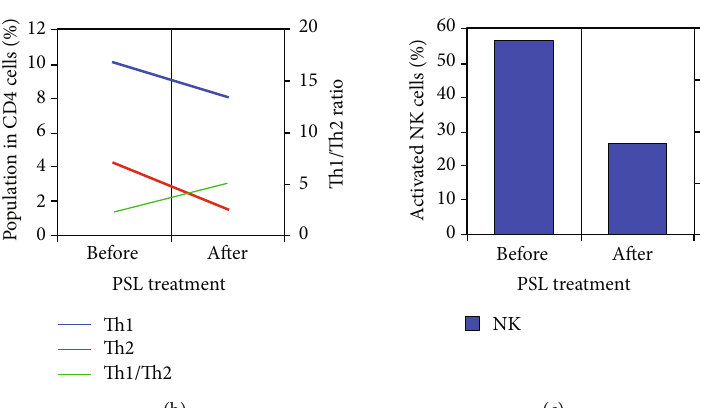
Figure 2: (a, A) Enhanced sensitivity of IL-12R and IL-23R leads to the di ff erentiation of naïve CD4+ cells to Th1 and Th17 cells (red arrows). (B) IL-1, produced mainly by macrophages, increases the number of Th2 cells via PGE2, and IL-12 and IL-18-activate NK cells (red arrows). (C) When Th17 induction is strong, the induction of regulatory T cells (Tregs) reduces (blue arrow), and immune tolerance cannot be reached. MØ: macrophage; Neutro: neutrophil. (b) Th1 cell fraction decreased from 10.1% to 8.1% after prednisolone (PSL) treatment; Th2 cell fraction decreased from 4.2% to 1.6%; and the Th1 to Th2 ratio increased from 2.4 to 5.1. (c) NK cell activity decreased from 56% to 26% after PSL treatment. The patient was administered 10 mg/day PSL for 4 weeks, which improved the immune